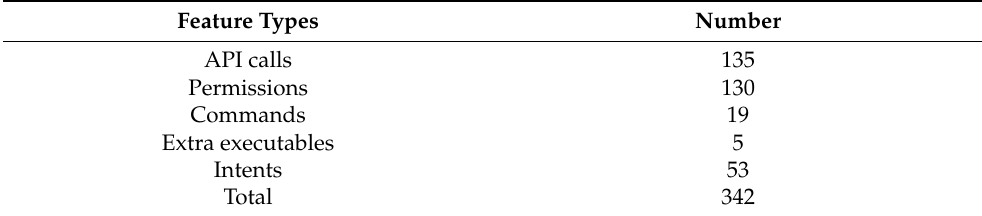
Table 1. The five types of features used in developing the deep learning